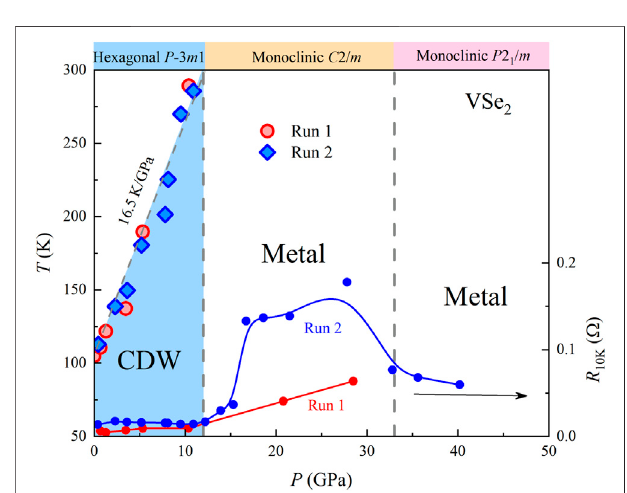
FIGURE 6 | Pressure-temperature phase diagram combined with structural phase information for 1 T -VSe 2 . The left y-axis: The pressure- dependent T CDW in Run 1 and Run 2, respectively. The right y-axis: Red (blue) circles represent the resistance values at 10 K extracted from the high- pressure resistance measurements of Run 1 (Run